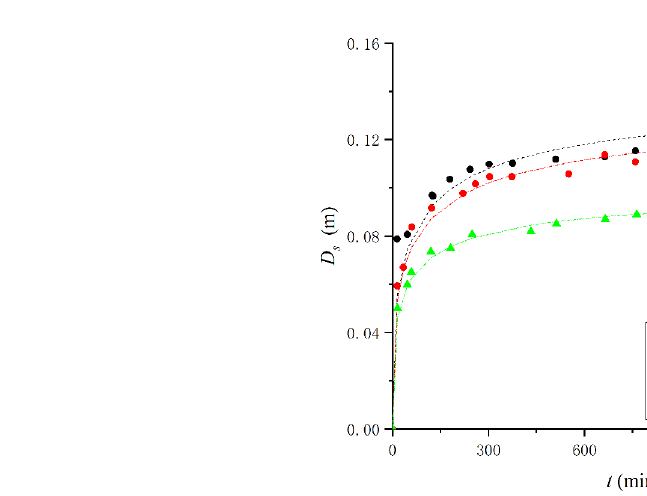
FIGURE 3 | Temporal development of scour in Amini et al. (2012). Experimental data of Galan et al. (2018) were also presented ( n = 2) in Table 3 as additional details.